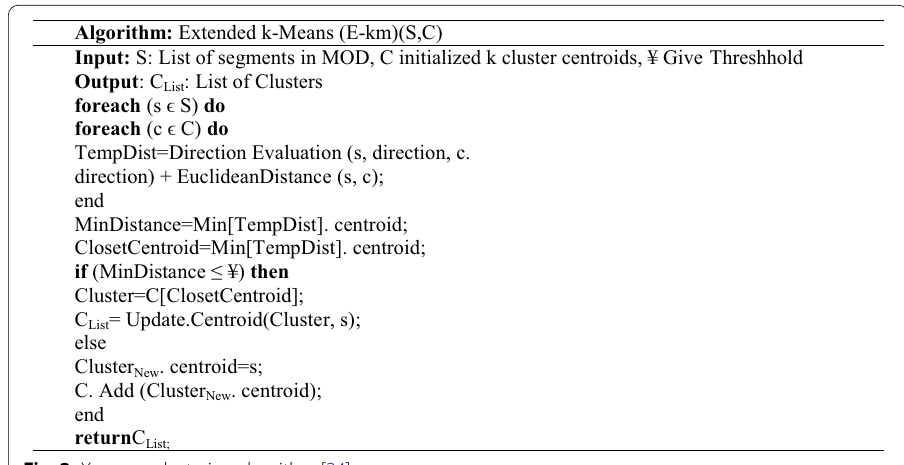
Fig. 2 X-means clustering algorithm